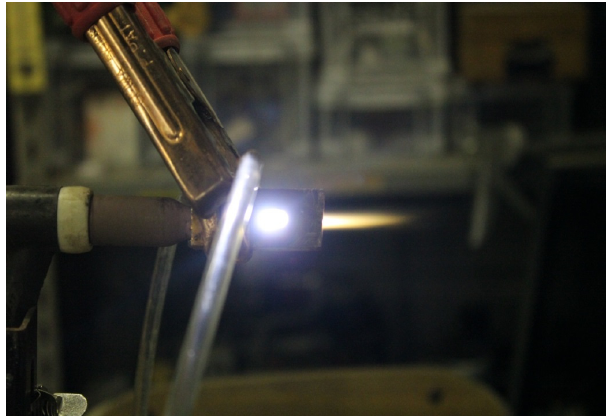
Figure 4. Plasma jet generated by our thermal spray equipment.